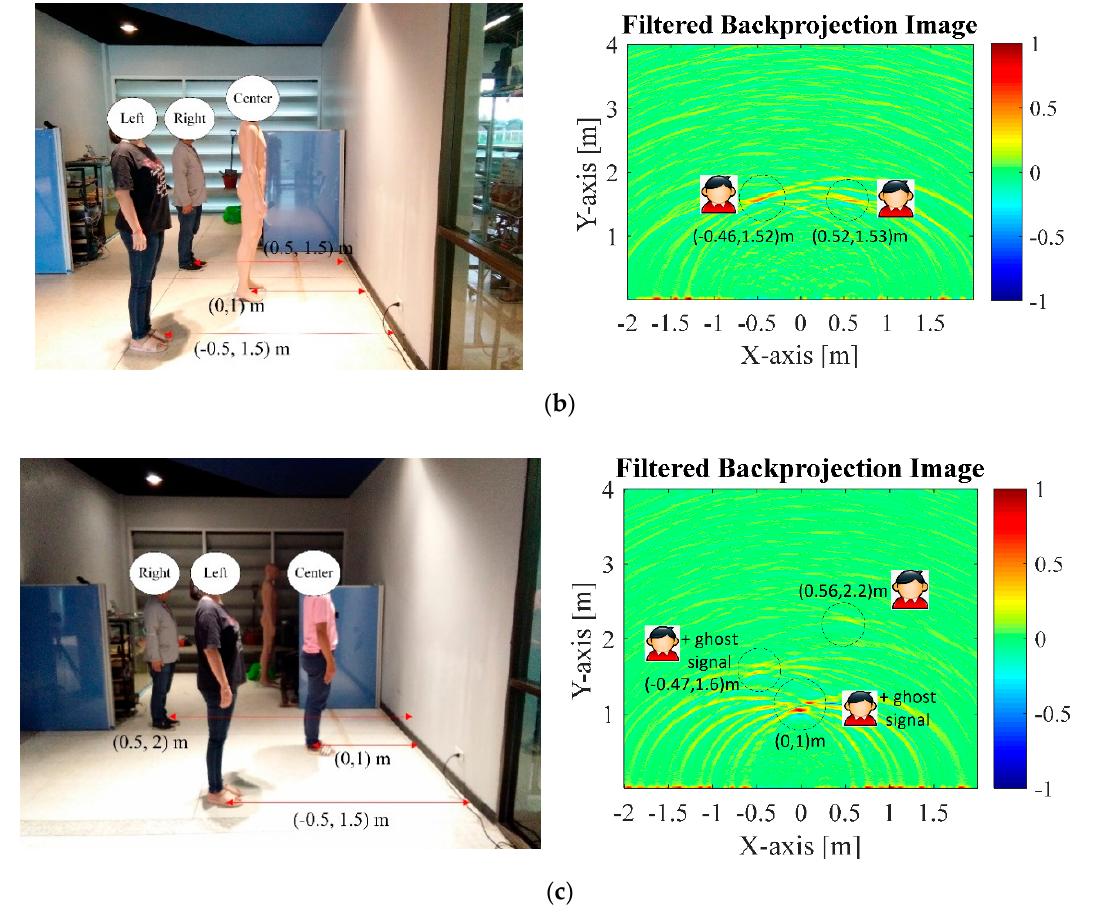
Figure 11. Through-the-wall detection: ( a ) a human (0.5 m, 1.5 m) and a mannequin (0, 1 m); ( b ) two humans ( − 0.5 m, 1.5 m) and (0.5 m, 1.5 m) a mannequin (0, 1 m); ( c ) three humans at ( − 0.5 m, 1.5 m), (0,1 m) and (0.5 m, 2 m).